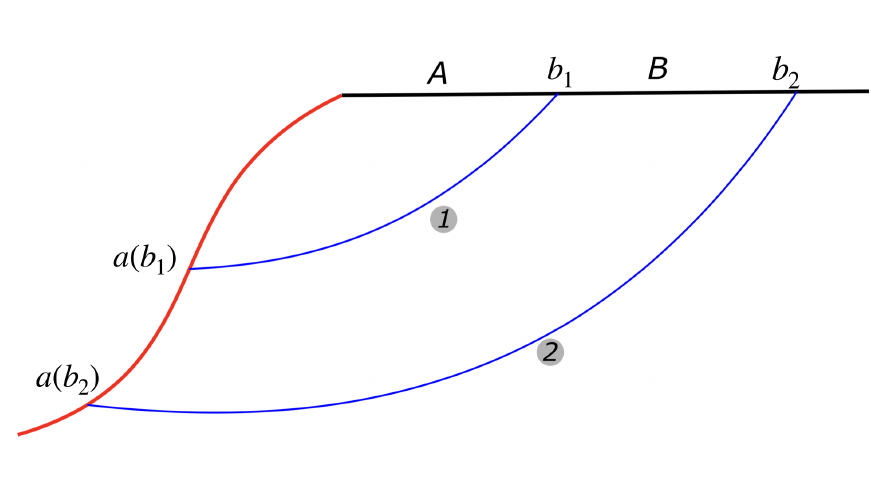
Figure 11: Schematic of the island proposal-I for the entanglement negativity of the mixed state of the adjacent intervals in